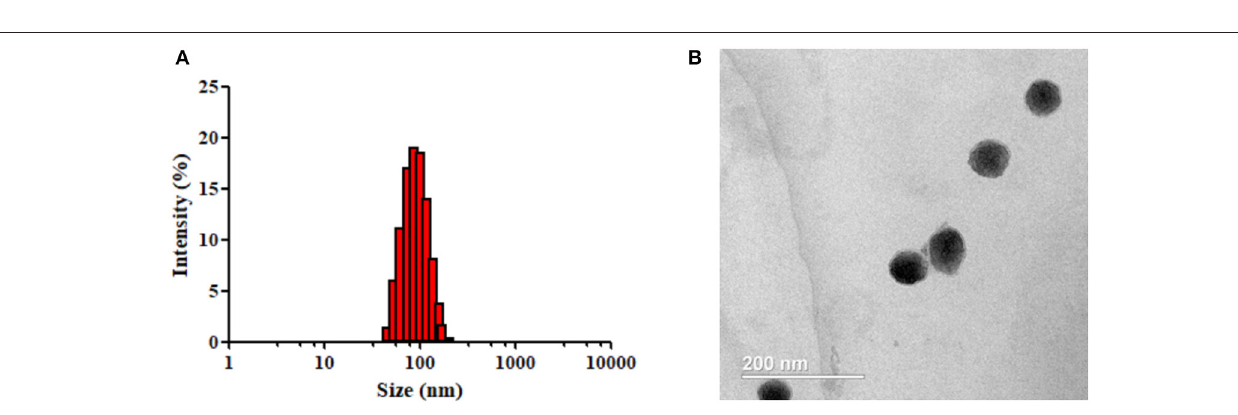
FIGURE 4 | (A) Size distribution and (B) TEM image of NP-TPGS-Pt.